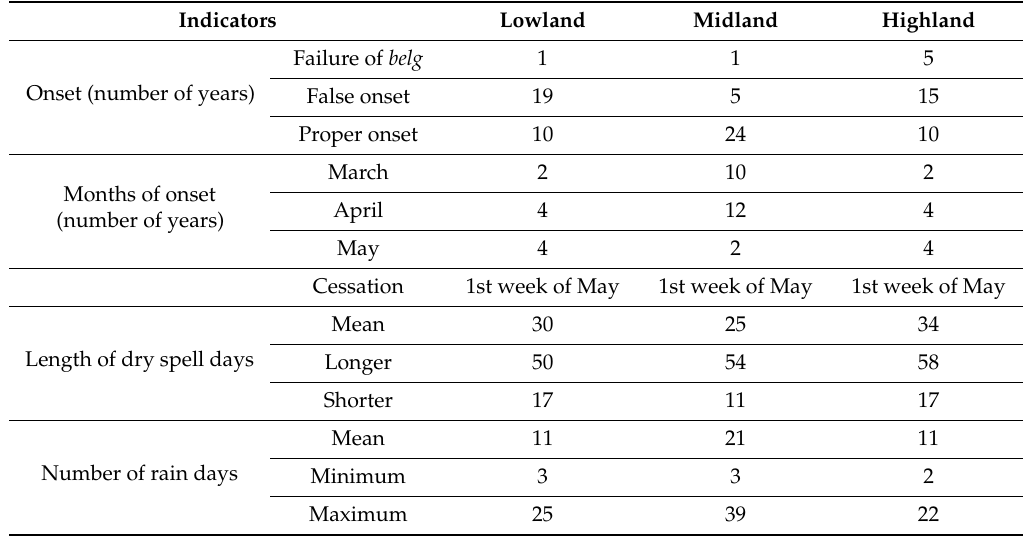
Table 4. Characteristics of belg season in three agro-ecological settings.